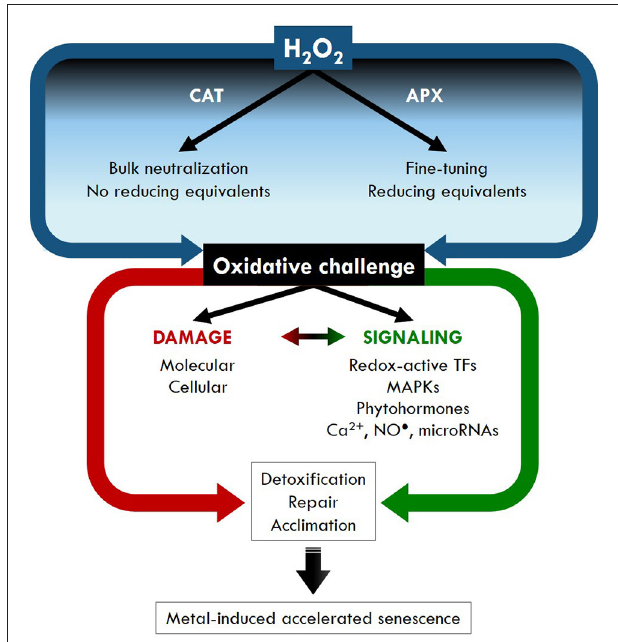
FIGURE 2 | Generalized model for the central role of hydrogen peroxide (H 2 O 2 ) in metal-induced oxidative damage vs. signaling responses. Ascorbate peroxidase (APX) and catalase (CAT) are the two most important enzymes that counterbalance metal-induced H 2 O 2 production in plants. However, APX has a much higher affinity for H 2 O 2 as compared to CAT. Therefore, the former enzyme is considered to be primarily involved in the fine-tuning of H 2 O 2 levels crucial for their signaling function. Conversely, CAT is important for the bulk removal of excess H 2 O 2 produced in stressed plants. In addition, while APX uses AsA as a reducing agent to detoxify H 2 O 2 , CAT does not need any reducing equivalents. Depending on its extent, the metal-induced rise in H 2 O 2 content can lead to molecular and cellular damage and/or signaling. Different studies highlight the interaction between ROS/H 2 O 2 and signaling components such as redox-active transcription factors (TFs), mitogen-activated protein kinases (MAPKs), phytohormones, Ca 2 + , NO • and regulating systems like miRNAs. Finally, detoxification, repair and acclimation responses are activated, with accelerated senescence as a potential last resort in metal-exposed